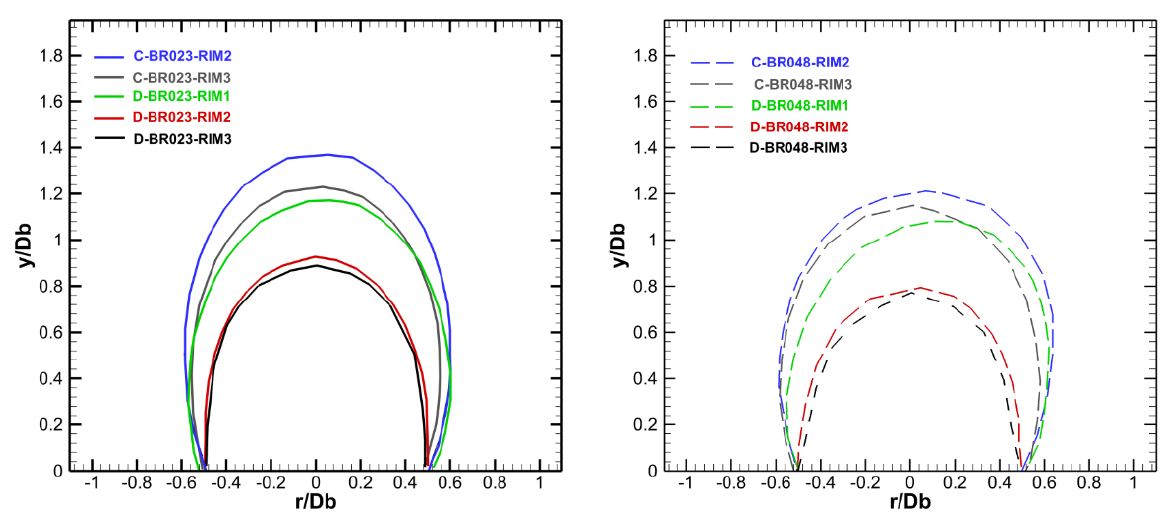
Figure 4. Locus of the separation streamline for each investigated cases. For cone shaped bluff bodies and smaller thickness disks, the location of the zero- streamline close to the bluff body trailing edge, indicates larger and positive (with respect to axial flow direction) flow deflection angles ranging from 18 ◦ to 34 ◦ (Table 1), causing a wider spread of the annular jet and of the subsequently developing wake. The thick disk baffles (D-RIM 2 and 3) result in a more streamlined flow with almost negative angles ranging from − 2 ◦ to − 5 ◦ , implying a diminishing radial velocity component contribution. Furthermore, the L/W ratio [4], which represents an approximate measure of the rate of spread of the recirculation zone, is given in Table 1, implying a relative independency from the geometry of the bluff body. More significantly, this ratio was found to decrease by 10–15% when doubling the blockage ratio, by 17–20% as we move from the cone to the disk and by 5% when increasing the bluff body